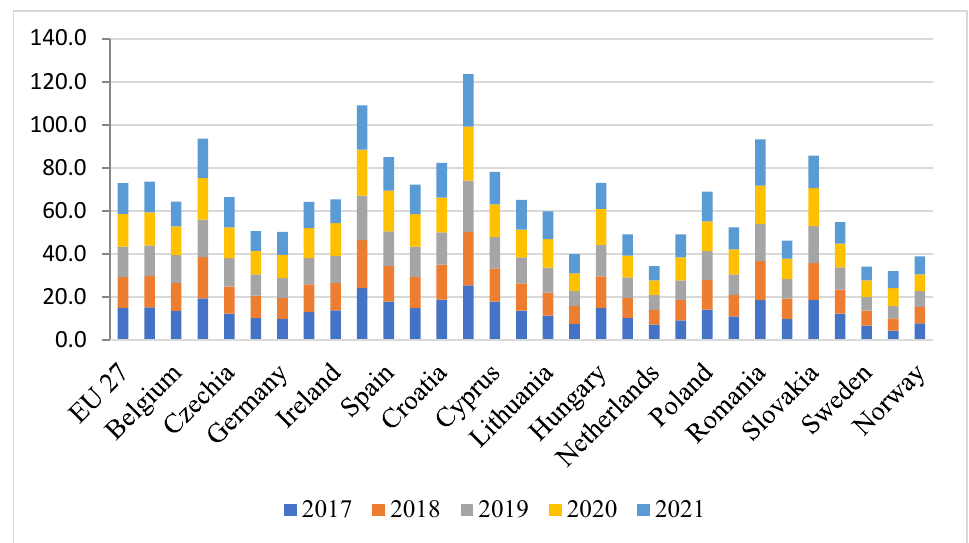
Figure 9. NEET in European countries, 2017–2021. Source: own elaboration on the Eurostat database.